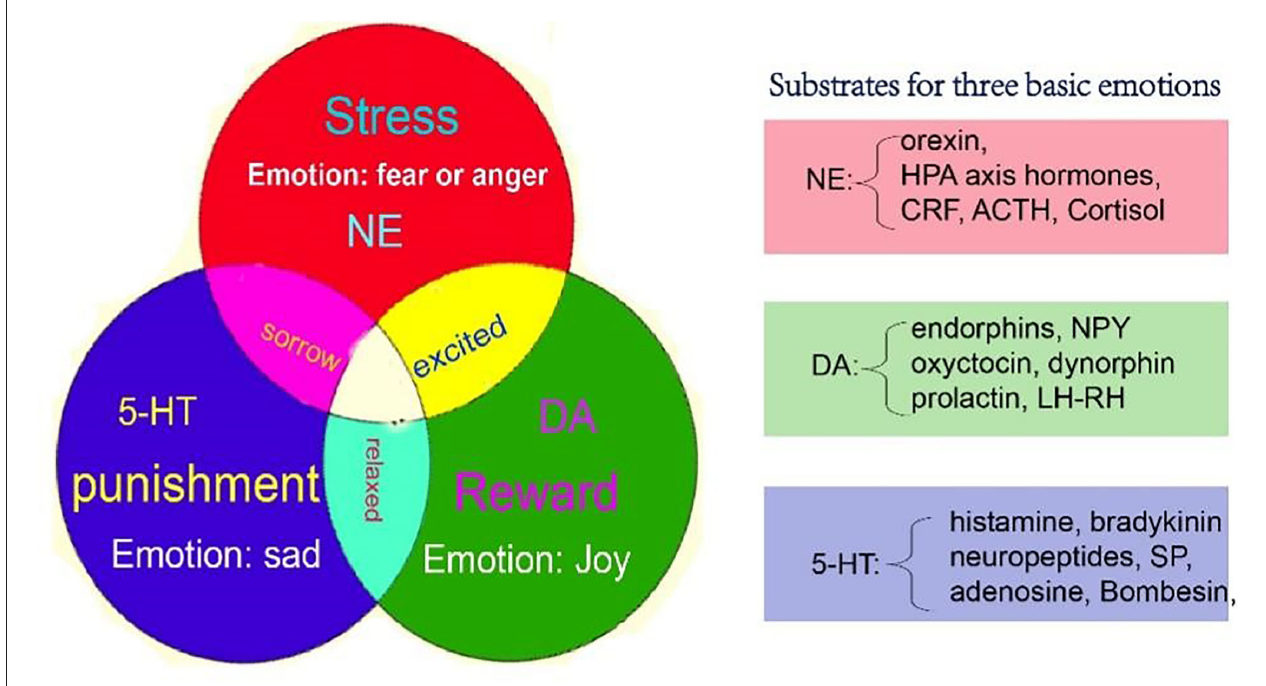
FIGURE 2 | A new model for basic emotions, which might be the neural mechanisms of PSD. The monoamine (NE, DA, and 5-HT) might be the substrate for basic emotions, which include joy, sadness (disgust), and fear (anger). [A figure from our previous paper, (61)]. NE, norepinephrine; DA, dopamine; 5-HT,